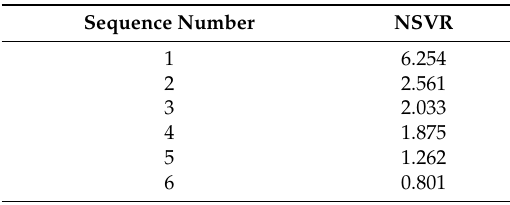
Table 1. The ratios of neighboring singular values.